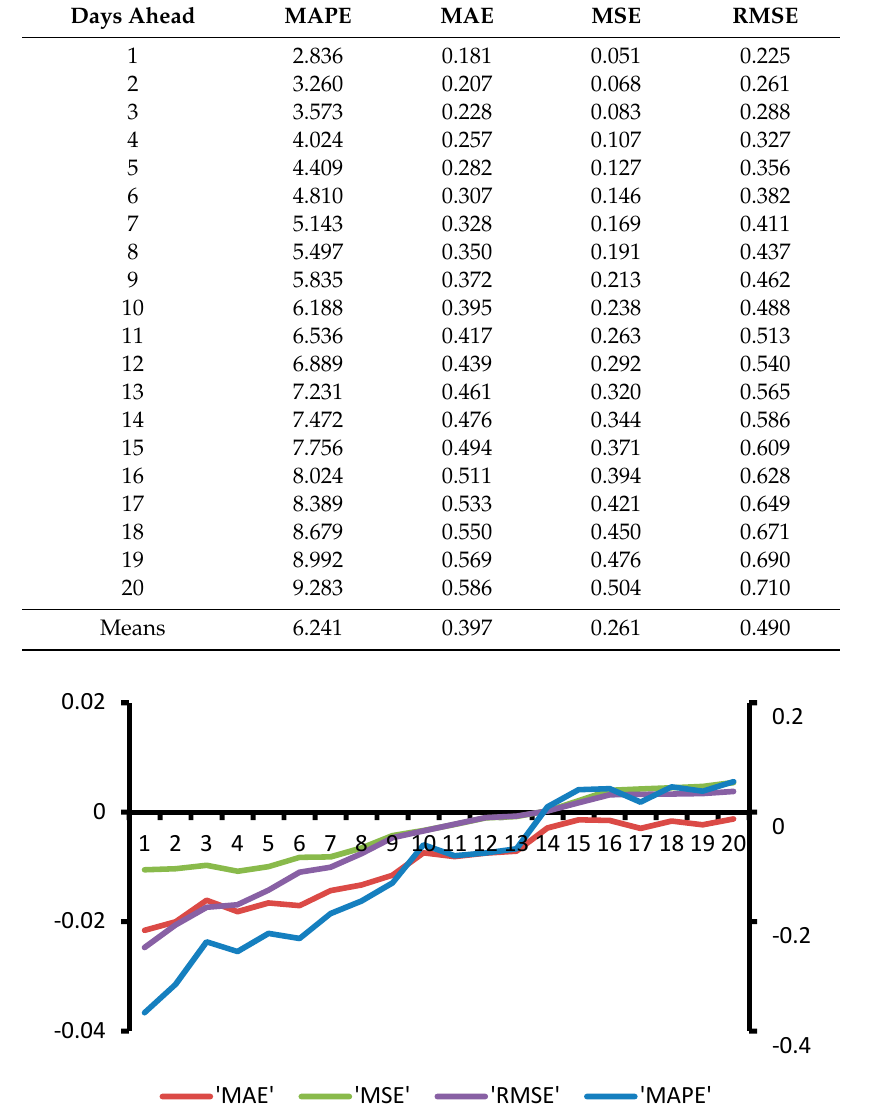
Table 4. Prediction errors of CO 2 emission allowance prices when electricity prices and iron and steel prices are also used as input variables.